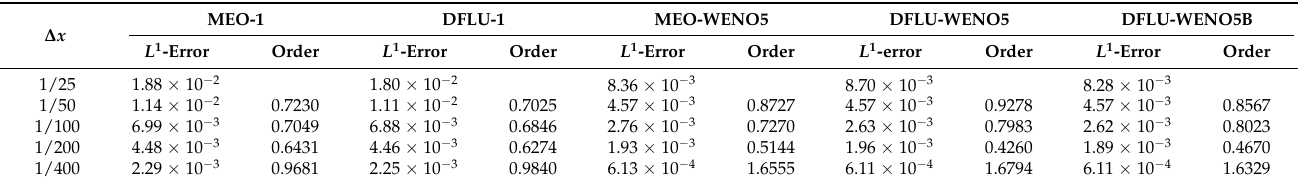
Table 1. L 1 -errors of two types of MEO and DFLU schemes for Example 1.